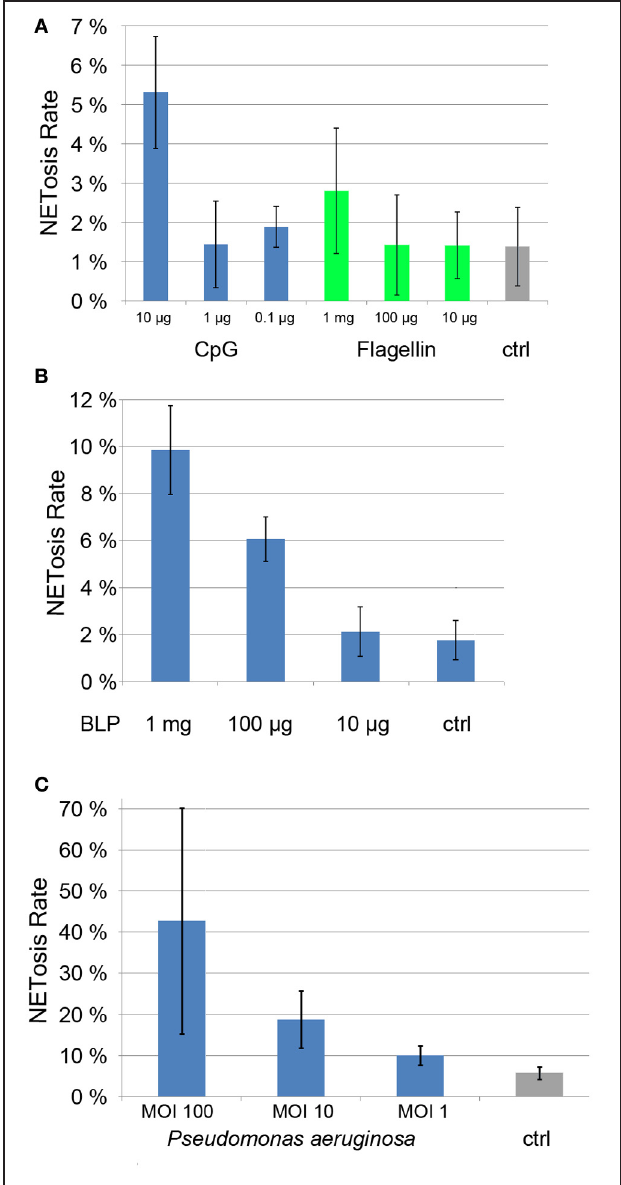
FIGURE 5 | NETosis rates of ligands of Toll-like receptors (CpG, Flagellin, panel 5A and BLP, panel 5B) as well as NETosis rate of neutrophils cocultured with Pseudomonas aergunisosa (panel 5C).